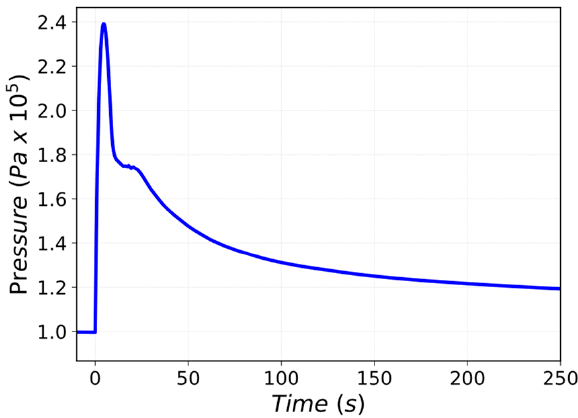
Figure 28. Pressure in the UPC.